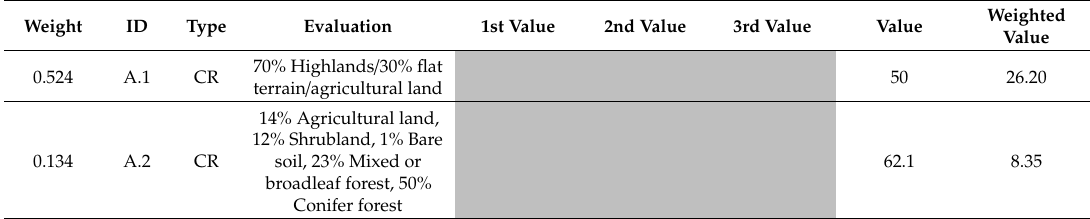
Table A15. Evaluation table of fire e ff ects on landscape and vegetation after the Evros fire. CR: